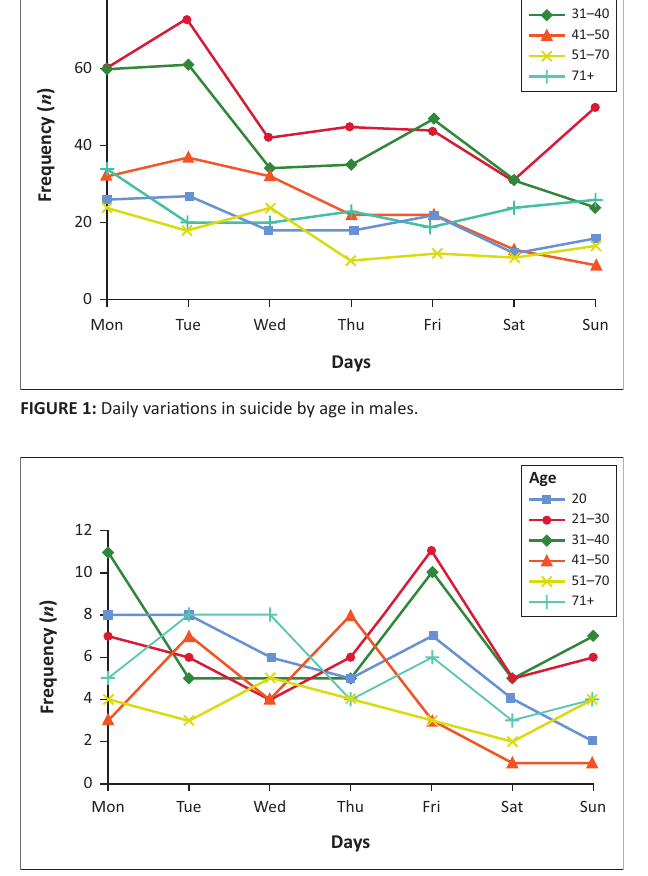
FIGURE 2 : Daily variation in suicide by age in females.